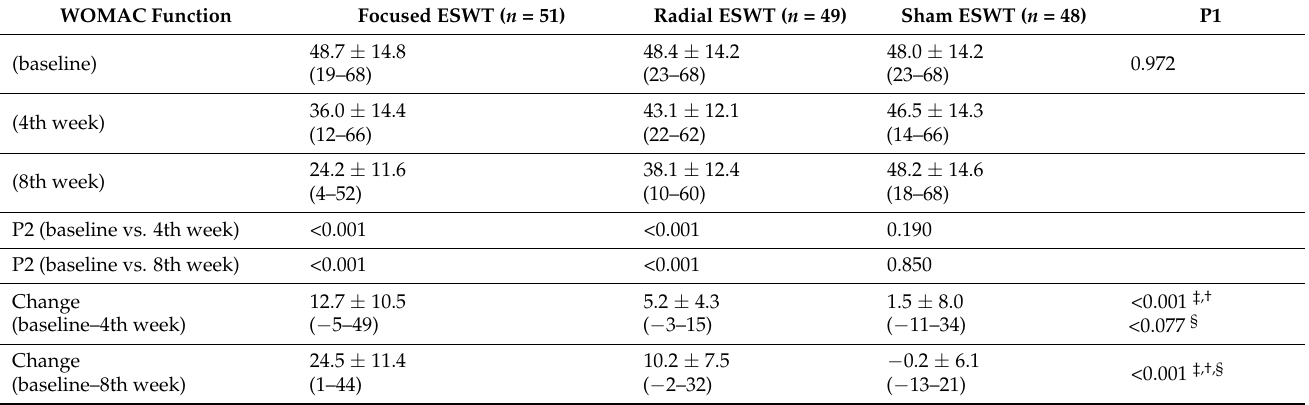
Table 5. Statistical analysis for the WOMAC function scores.